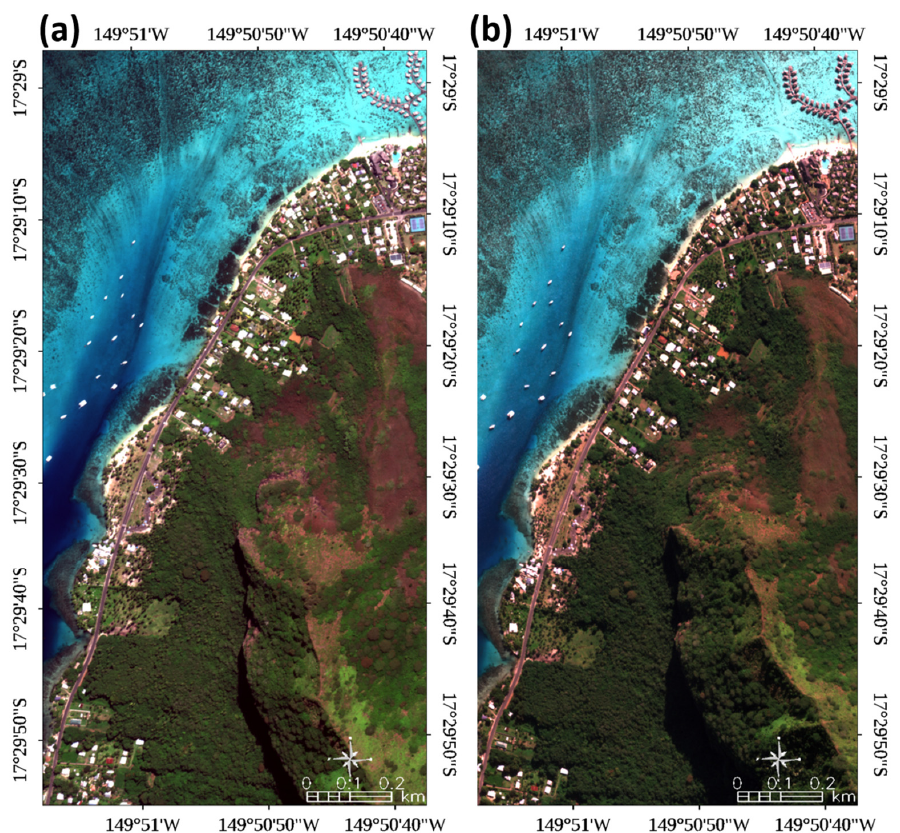
Figure 3. Natural-coloured WorldView-3 imageries of the study area, taken on 18 July 2018, over the north shore of Moorea Island (French Polynesia). ( a ) Imagery #1 taken with 26.4 ◦ off-nadir viewing angle; ( b ) Imagery #2 taken with 16.5 ◦ off-nadir viewing angle. Table 2. WorldView-3 specifications related to the stereo-imagery acquisition over the study site.